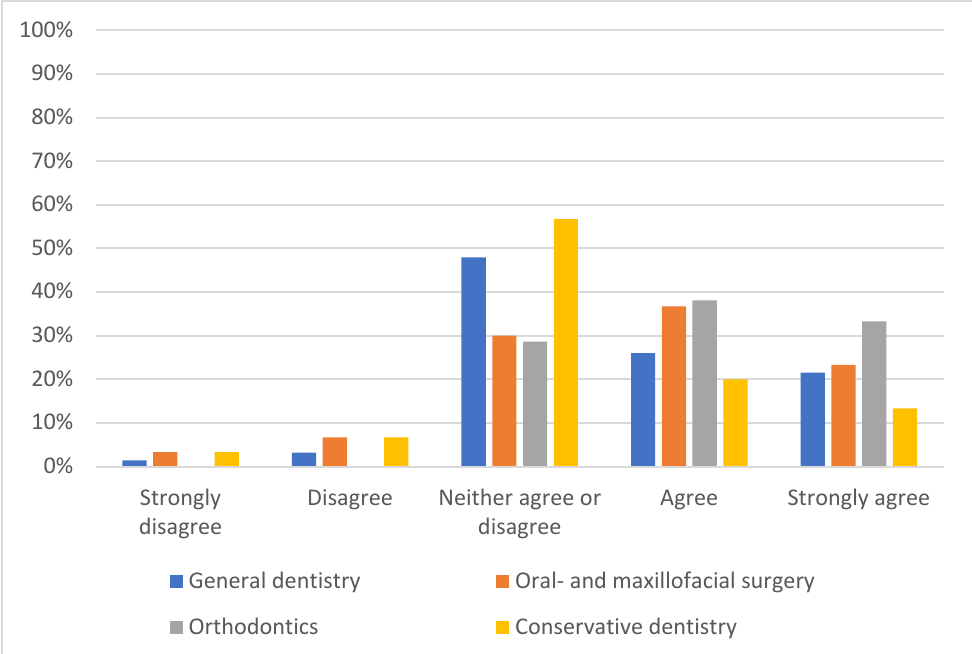
Figure 3. Approval rating of the statement “The introduction of AI will lead to improvement in my profession.”.